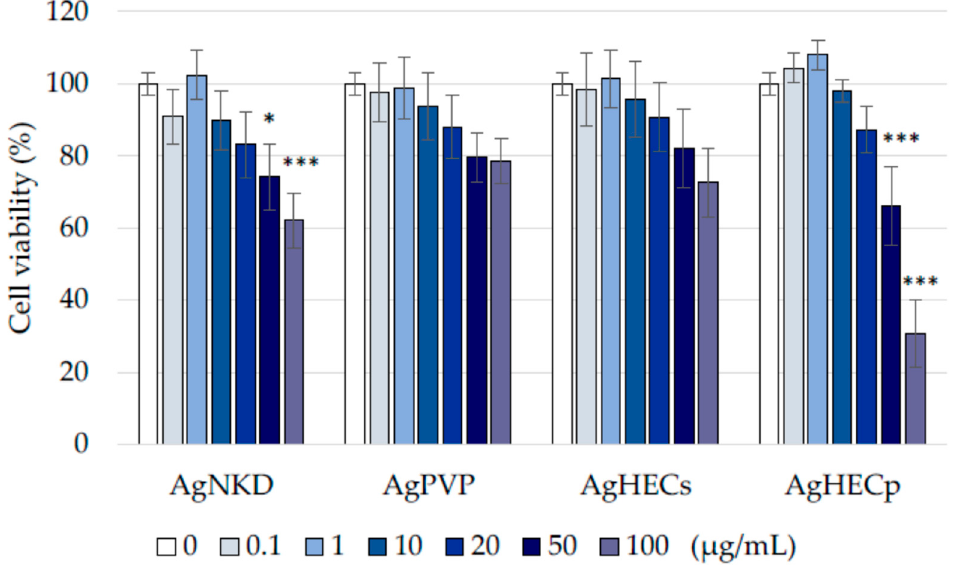
Figure A3. Cell viability assessed by Alamar Blue at 48 h. A significant reduction in cell viability was observed after AgHECp and AgNKD. AgPVP and AgHECs particles were less effective. One-way ANOVA followed by Dunnett’s test; * p < 0.05; *** p < 0.001 compared to control cells. N = 3.